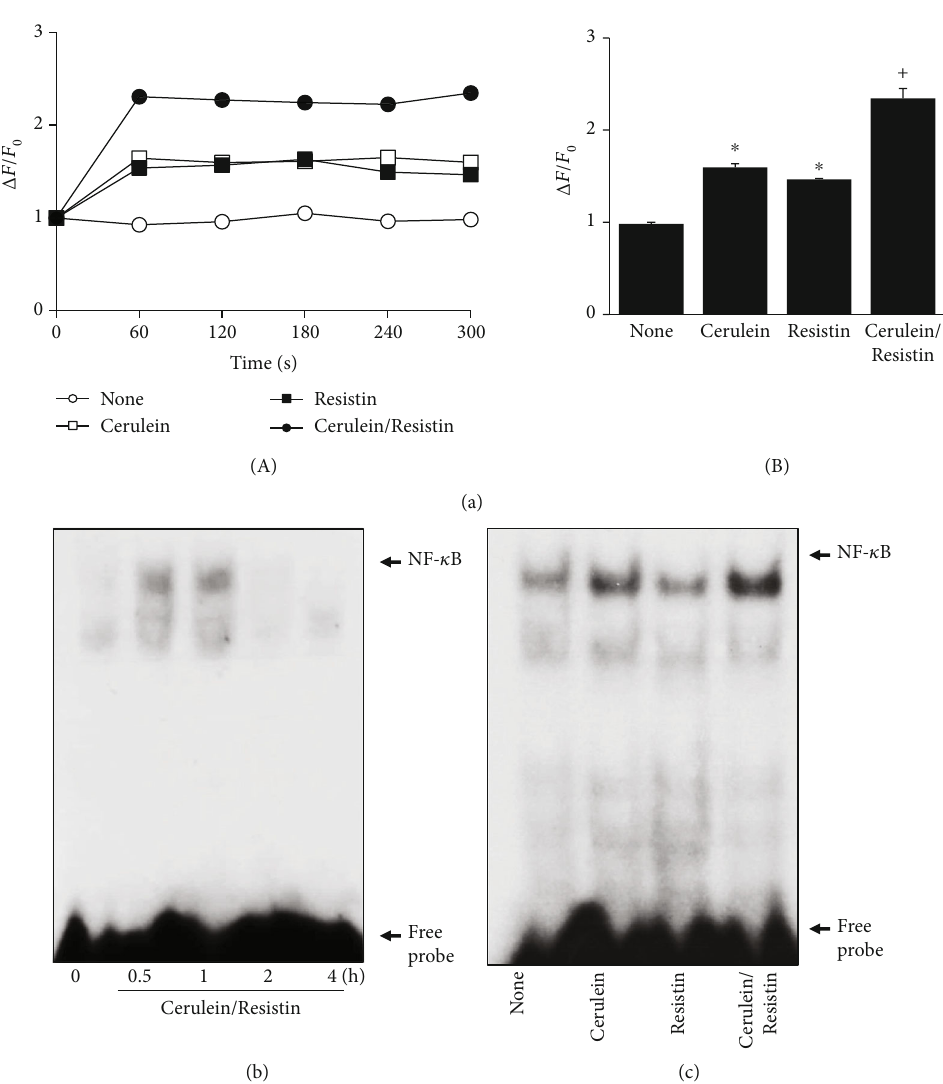
Figure 2: Resistin enhances cerulein-induced Ca 2+ overload and NF- κ B activation in AR42J cells. (a) The cells were stimulated with cerulein in the presence or absence of resistin for the indicated times. Ca 2+ level was determined by measuring the fl uorescence changes of fl uo-4 AM at excitation and emission wavelengths of 494 nm and 525nm, respectively. Ca 2+ levels were expressed as Δ F / F 0 , where F 0 is the resting background fl uorescence, and Δ F is fl uorescence change over time after treatment with or without cerulein in the presence or absence of resistin. Fluorescence transient changes (obtained within 1-5 min) were plotted (A). (B) Ca 2+ levels, expressed as Δ F / F 0 , of the cells. Data are expressed as the mean ± S : E : of three di ff erent experiments. Ca 2+ level in none (untreated cells) was set as 1. ∗ p < 0 : 05 vs. 0 min (a) or none (untreated cells; b, c); + p < 0 : 05 vs. cerulein (cells treated with cerulein alone). (b) The cells were stimulated with cerulein/resistin for the indicated times. (c) The cells were stimulated with cerulein in the presence and absence of resistin for 1h. NF- κ B-DNA binding activity was determined by electrophoretic mobility shift assay